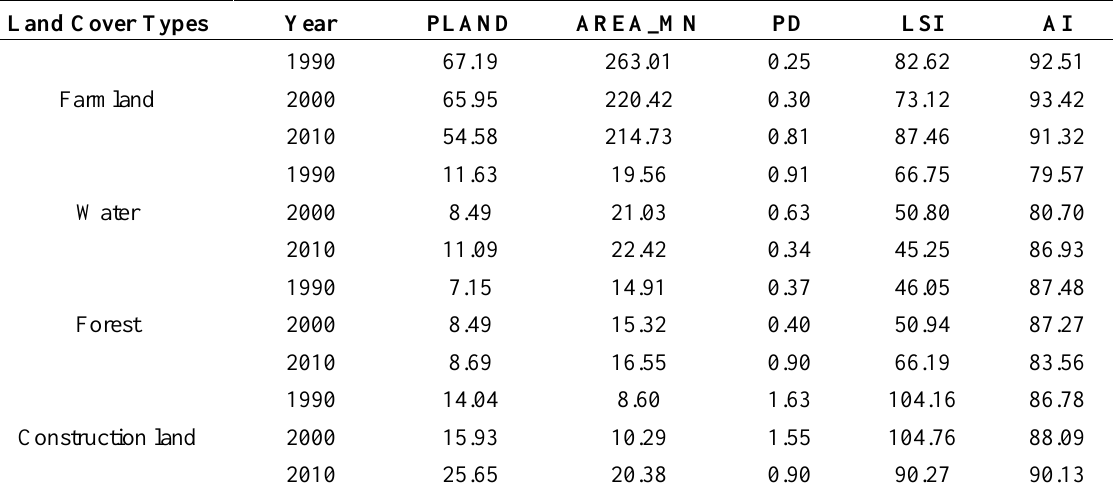
Table 3. Class-level indexes from 1990 to